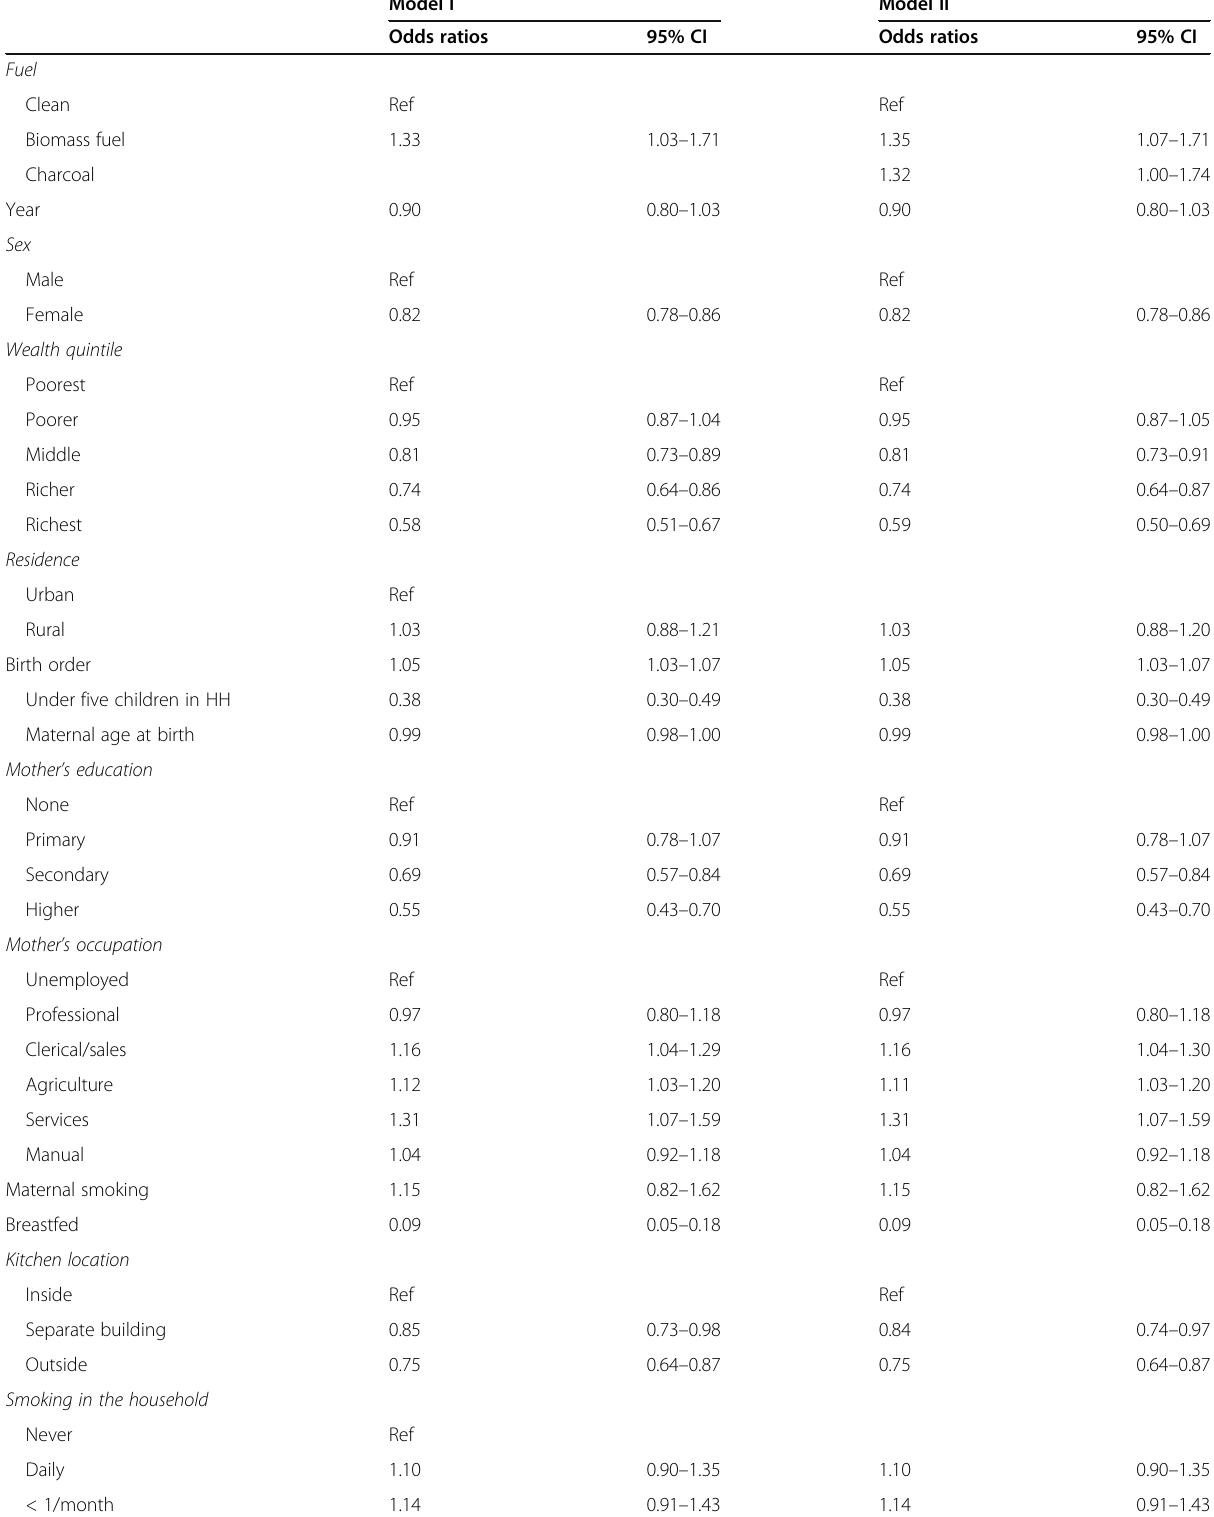
Table 2 Association of HAP exposure and other risk factors with under-five